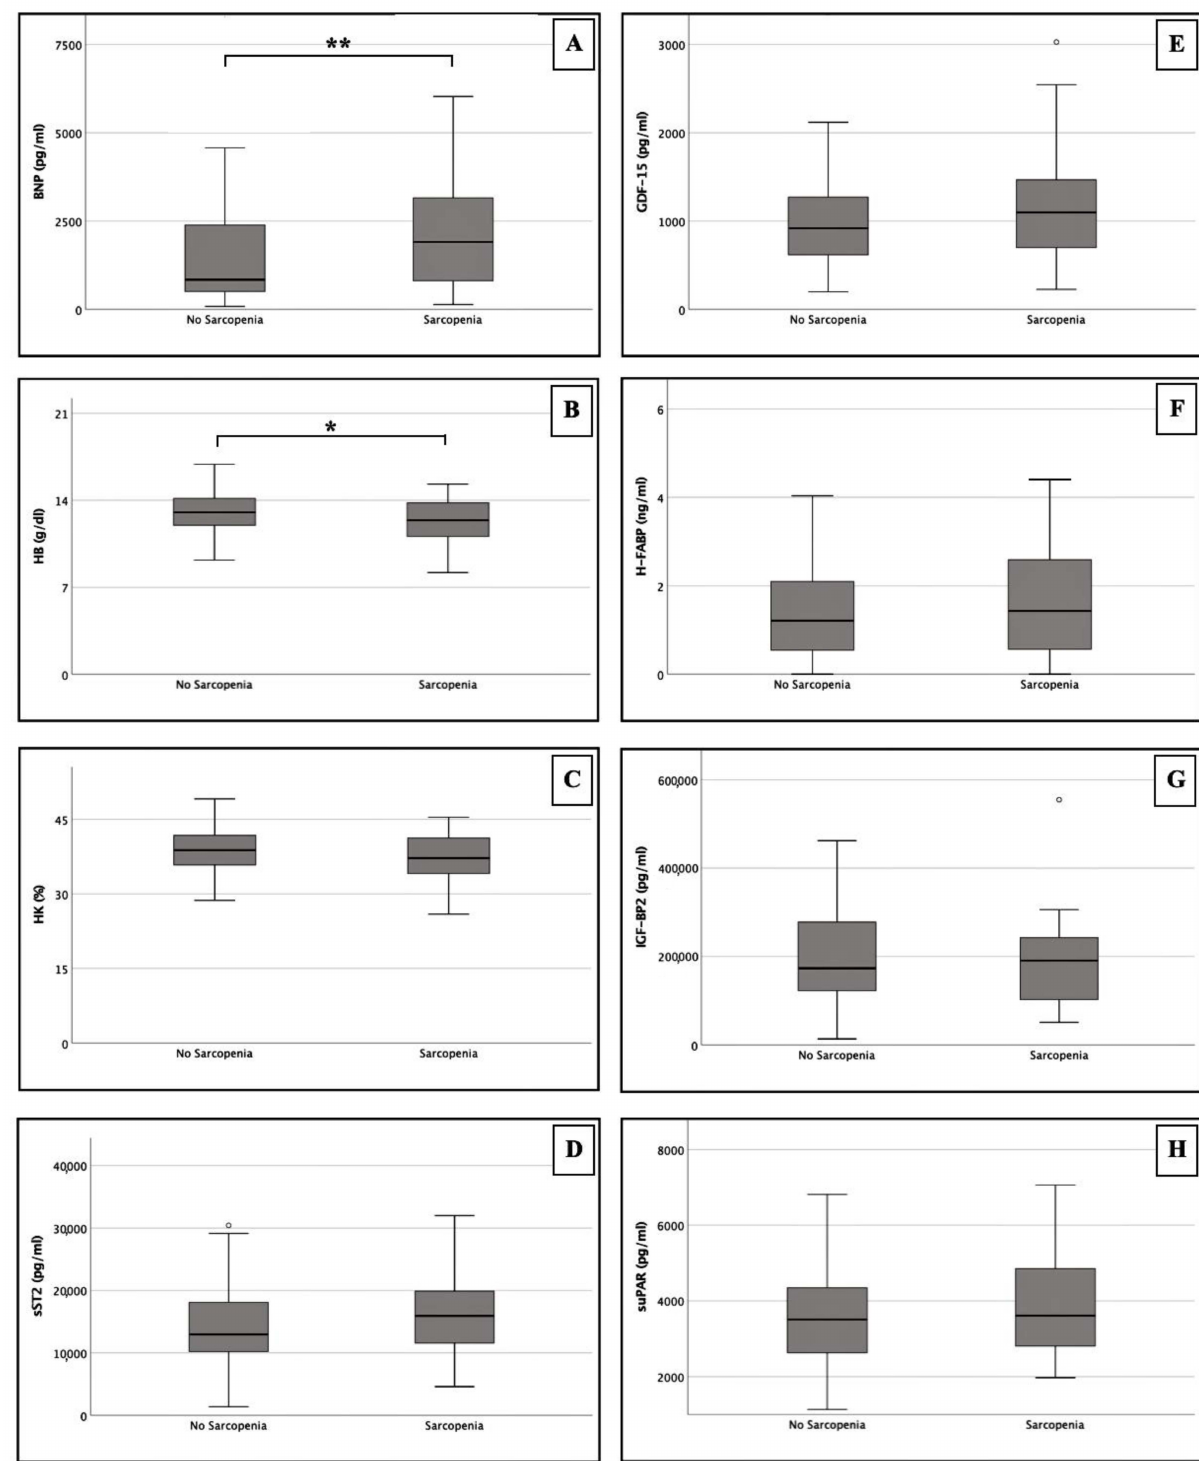
Figure 4. Serum concentrations of BNP ( A ), HB ( B ), HK ( C ), sST2 ( D ), GDF-15 ( E ), H-FABP ( F ), IGF-BP2 ( G ) and suPAR ( H ) in patients with radiological sarcopenia and no radiological sarcopenia; * p ≤ 0.05; ** p ≤ 0.01; ◦ outlier. BNP: brain natriuretic peptide; HB: hemoglobin; HK: hematocrit; sST2: soluble suppression of tumorigenicity-2; GDF-15: growth/differentiation of factor-15; H-FABP: heart-type fatty-acid binding protein; IGF-BP2: insulin like growth factor binding protein 2; suPAR: soluble urokinase- type plasminogen activator